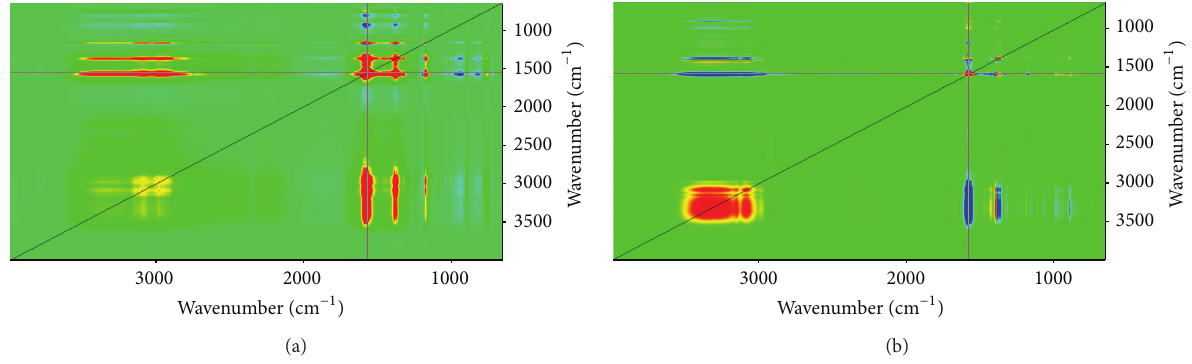
Figure 7: Two-dimensional FTIR correlation analysis of cellulose in EMIMOAc solution. Full spectrum range (400 to 4000 cm −1 ) synchronous spectra on heating (a) and cooling